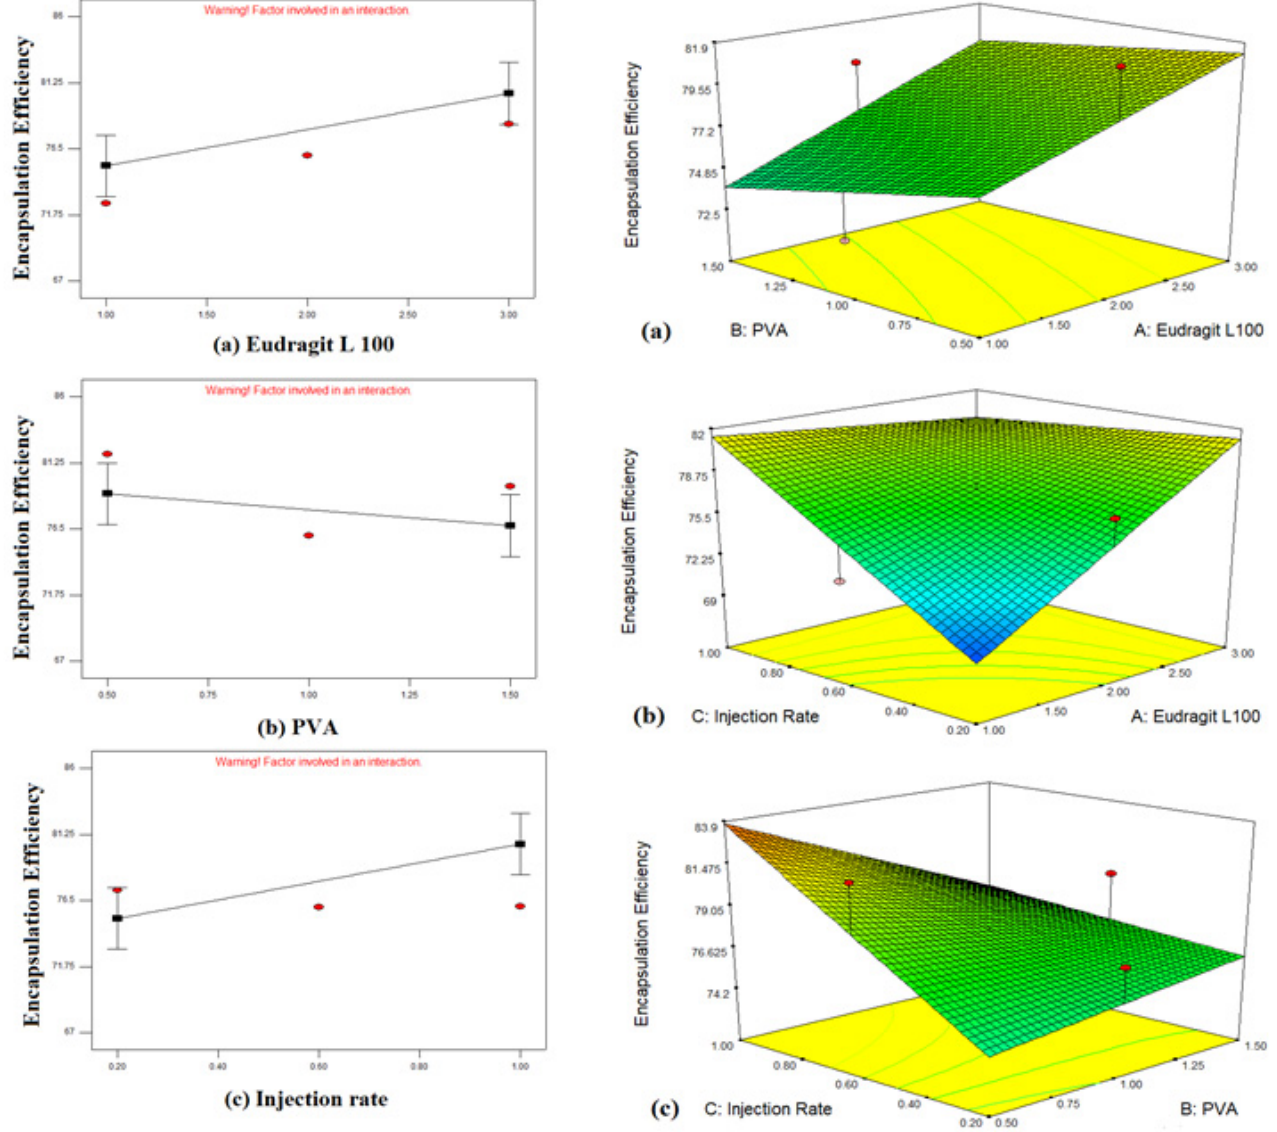
Figure 4. Graphical representation of the impact of independent variables on encapsulation efficiency of bergenin-loaded nanoparticles. ( a ) EL 100 ( b ) PVA ( c ) organic phase injection rate and 3-D response surface plot ( a ) PVA and EL 100 ( b ) organic phase injection rate and EL 100 ( c ) organic phase injection rate and PVA.